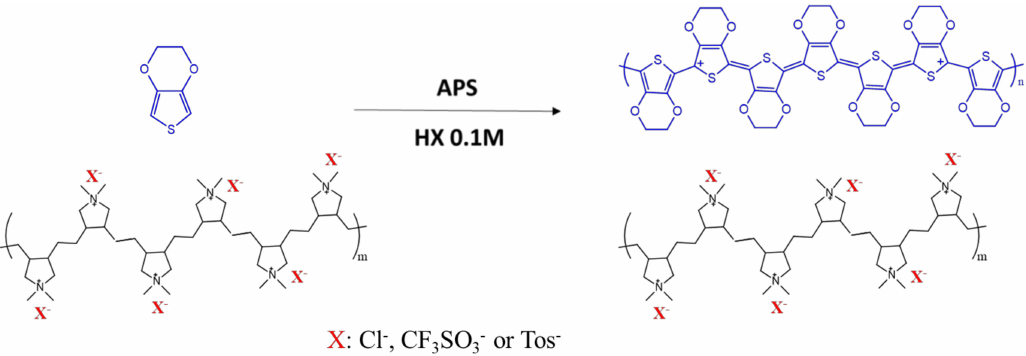
Figure 5. Synthesis of PEDOT:PolyDADMA